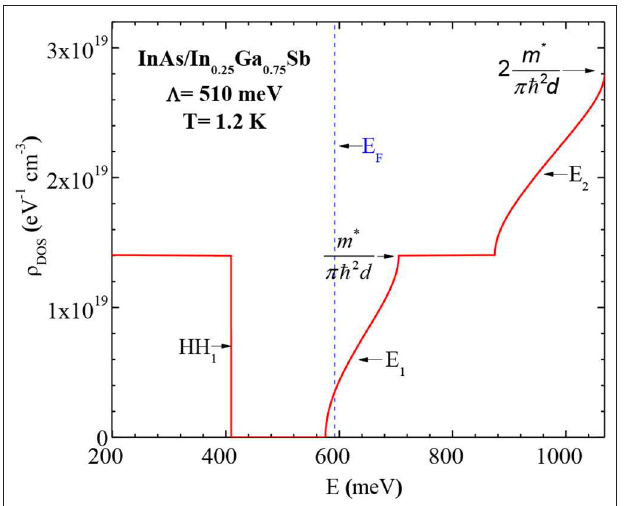
FIGURE 7 | The SL DOS of the three subbands HH1, E 1 , and E 2 at 1.2 K. The vertical dashed line indicates the position of the Fermi level energy E F .